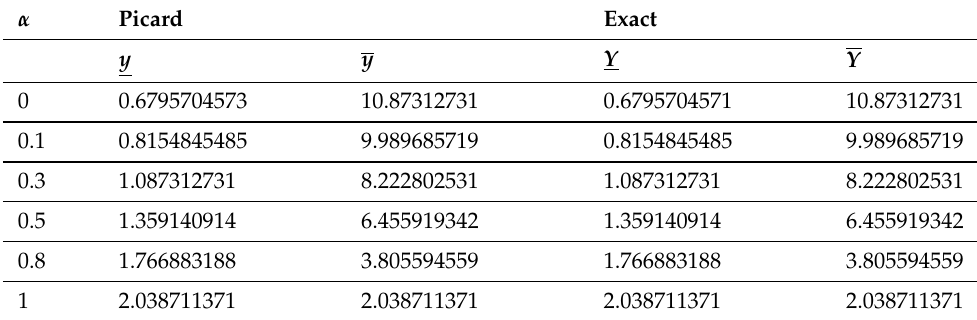
Table 7. Exact and numerical values (Picard’s method) for the 1-solution at t = 1.